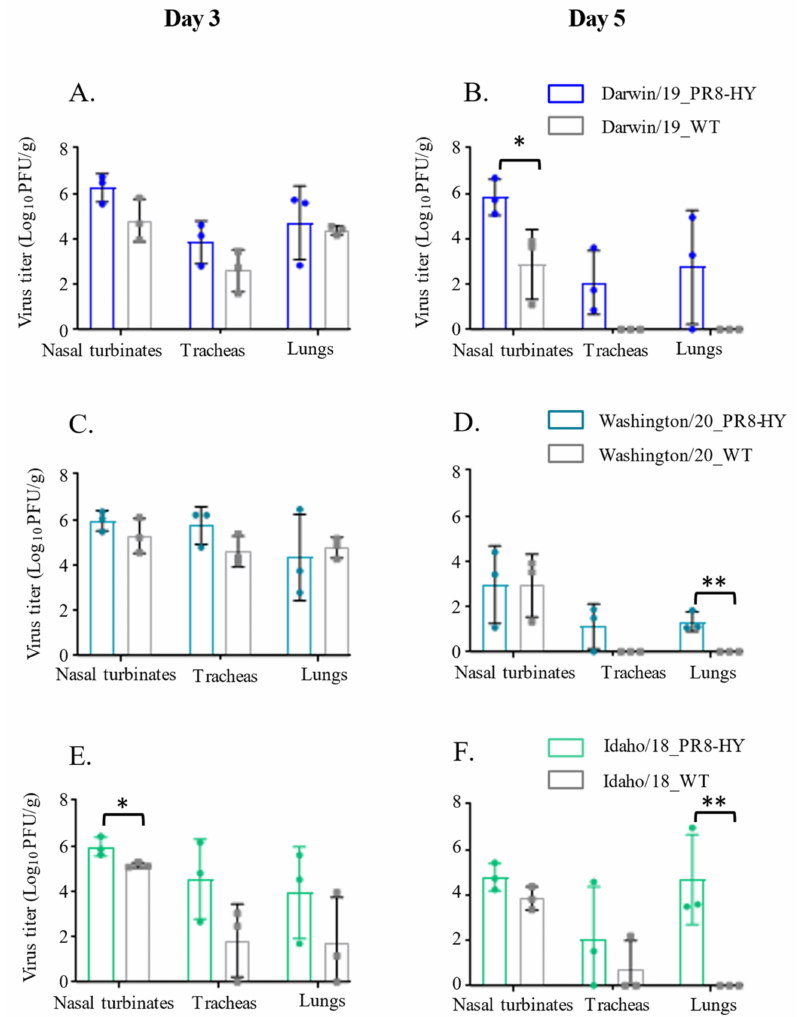
Figure 3. Replication of authentic and PR8-HY-based human pdmH1N1 viruses in Syrian hamsters. Six Syrian hamsters were infected with 10 6 PFU of the indicated virus or recombinant virus with the respective HA and NA genes on the PR8-HY backbone. On days 3 and 5 p.i., three animals from each group were euthanized and virus titers in the nasal turbinates, tracheas, and lungs were determined in hCK cells. * p < 0.05; ** p < 0.01. ( A , C , E ) show the titers of the indicated viruses in hamsters on day 3 post-infection; ( B , D , F ) show the titers of the indicated viruses in hamsters on day 5